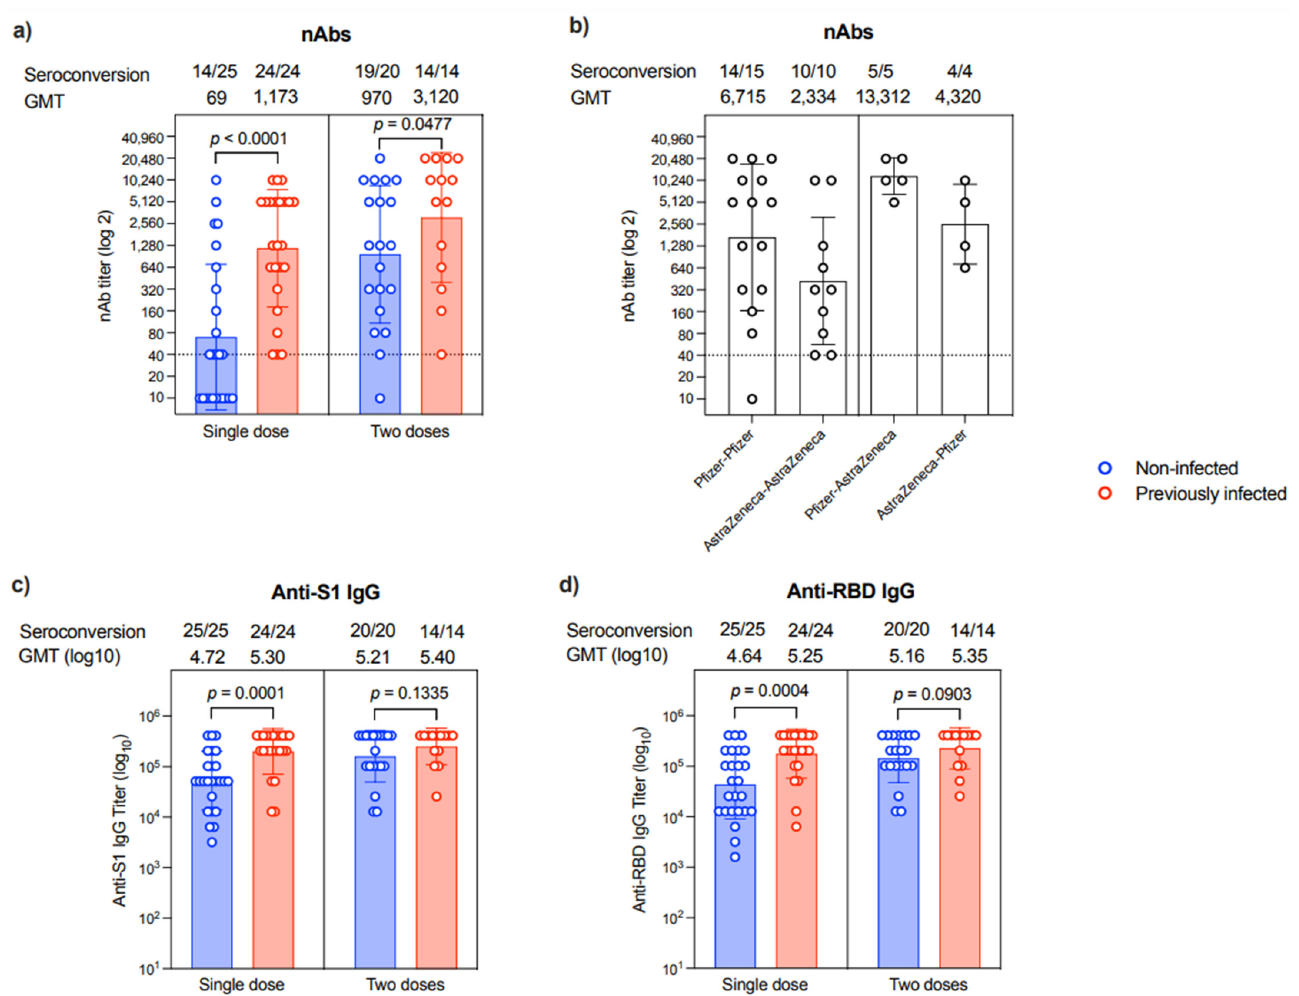
Figure 2. Antibody response. ( a ) Level of nAb response as end-point titer after a single dose or two doses of the different COVID-19 vaccines in non-infected (n = 25 in single-dose group and n = 20 in two-dose group) or previously infected ( n = 24 in single-dose group and n = 14 in two-dose group) individuals. ( b ) Levels of nAb response as end-point titer after two doses of the different homologous or heterologous combinations of Pfizer and AstraZeneca COVID-19 vaccines. ( c ) Levels of anti-S1 binding IgG response as end-point titer after a single dose or two doses of the different COVID-19 vaccines in non-infected ( n = 25 in single-dose group and n = 20 in two-dose group) or previously infected ( n = 24 in single-dose group and n = 14 in two-dose group) individuals. ( d ) Levels of anti-RBD binding IgG response as end-point titer after a single dose or two doses of the different COVID-19 vaccines in non-infected ( n = 25 in single-dose group and n = 20 in two-dose group) or previously infected ( n = 24 in single-dose group and n = 14 in two-dose group) individuals. Data are reported as geometric mean titer ± standard deviation. Numbers of seroconverted individuals and mean titers are shown on the top of the panels. Statistical analysis was done using the Mann–Whitney test. The dotted line in ( a , b ) is the cut-off at 1:40.